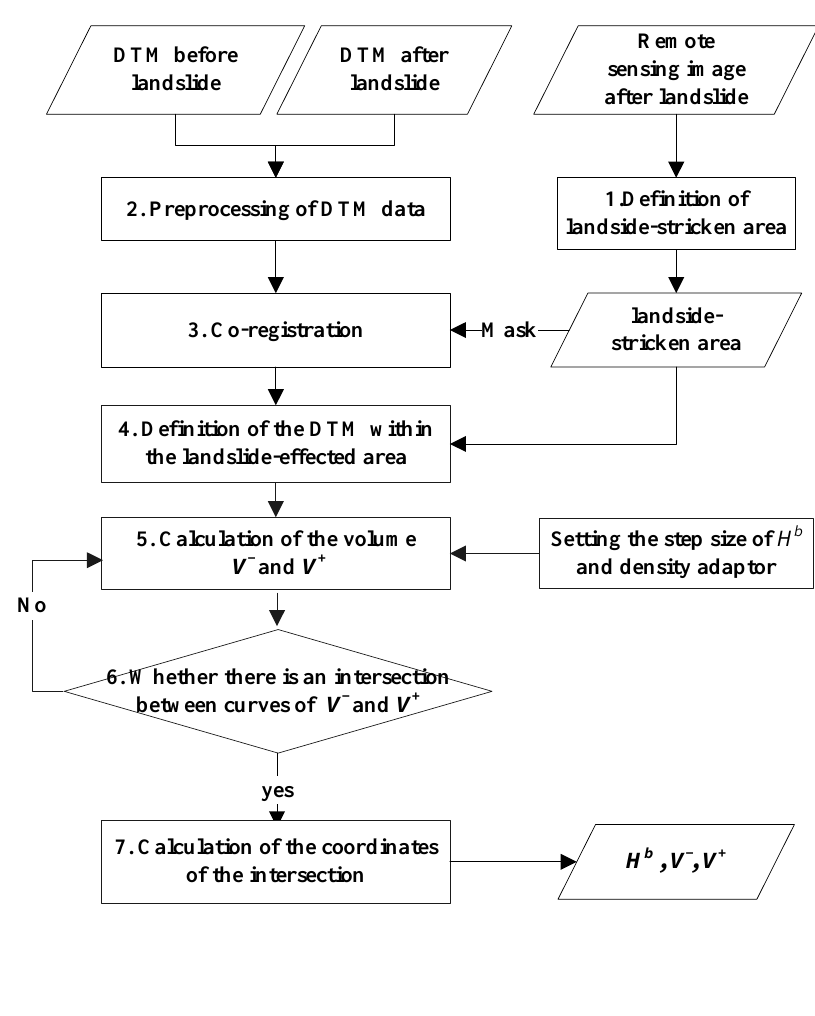
Figure 3. Workflow of the proposed model